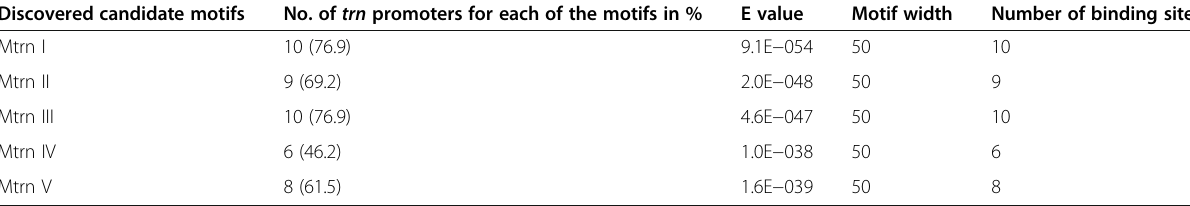
Table 2 Identified common candidate motifs of mitogenome promoter regions of M. anisopliae Discovered candidate motifs No. of trn promoters for each of the motifs in % E value Motif width Number of binding